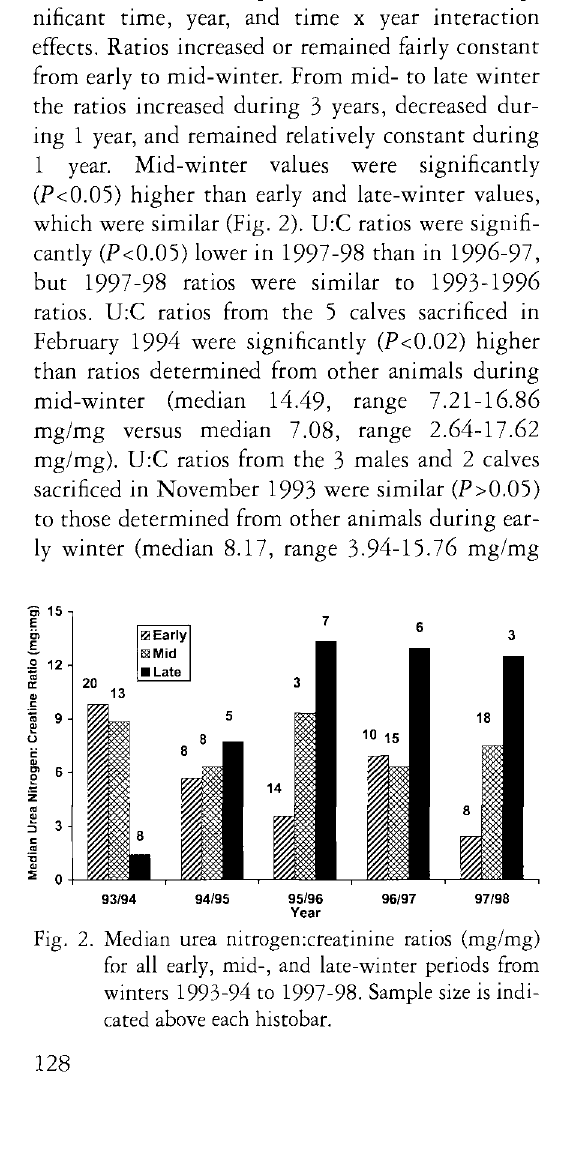
Fig. 3. Median cortisolxreatinine ratios (pg/mg) for all early, mid-, and late-winter periods from winters 1993-94 to 1997-98. Sample size is indicated above each